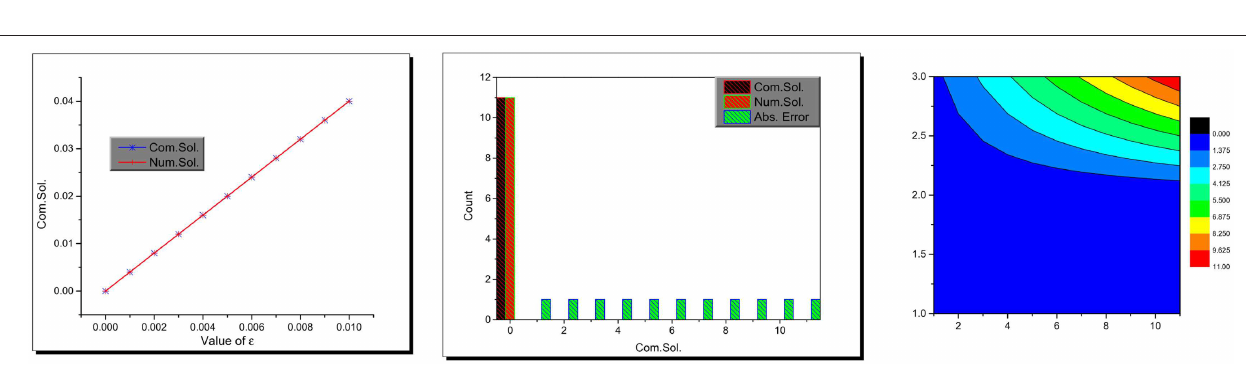
FIGURE 3 | Combined, bar, and contour plots of the computational, numerical, and absolute error values.